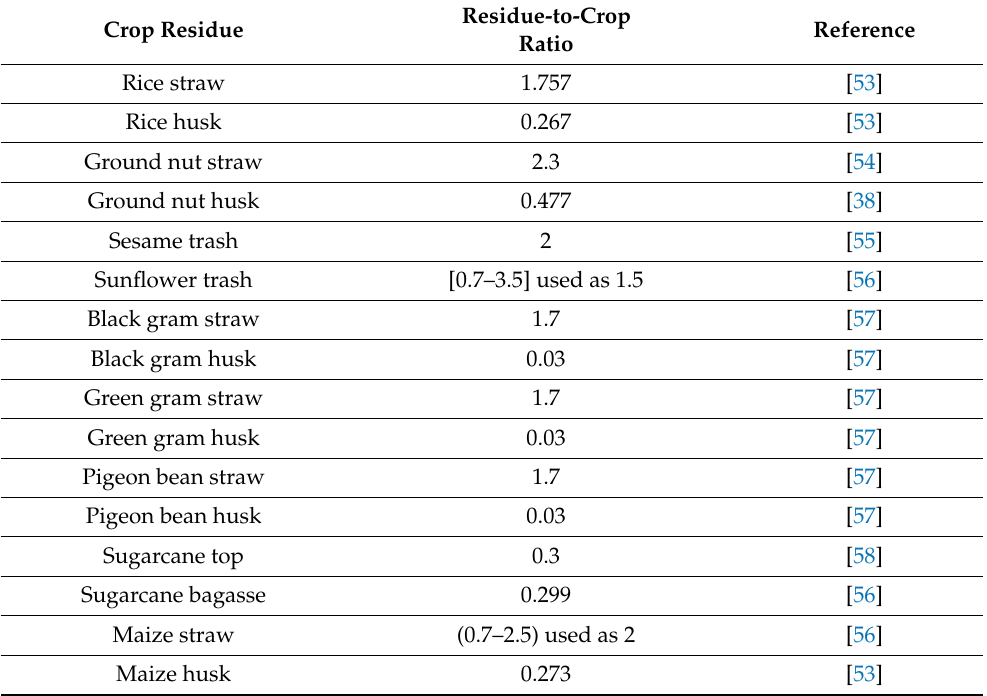
Table A2. Type of Crop Residue and RPR